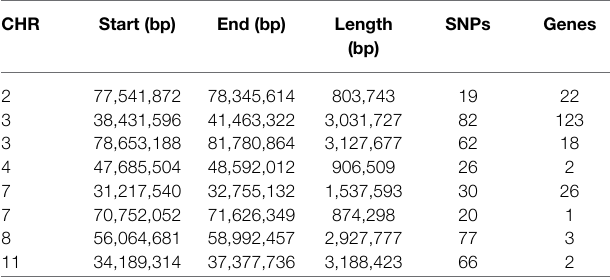
TABLE 2 | List of genomic regions of extended homozygosity detected in Xidu black